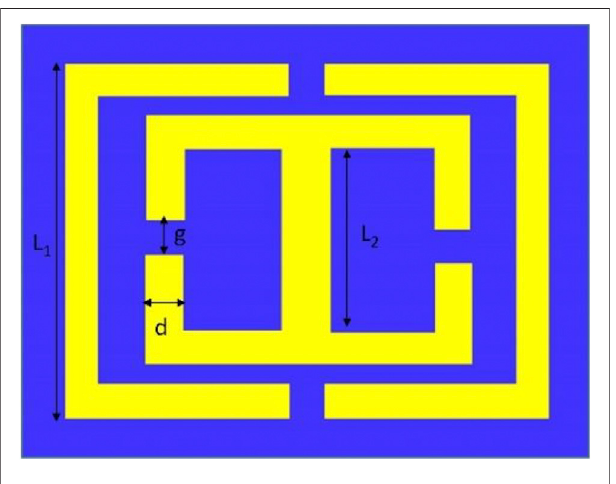
FIGURE 10 | Simulated unit cell structure.